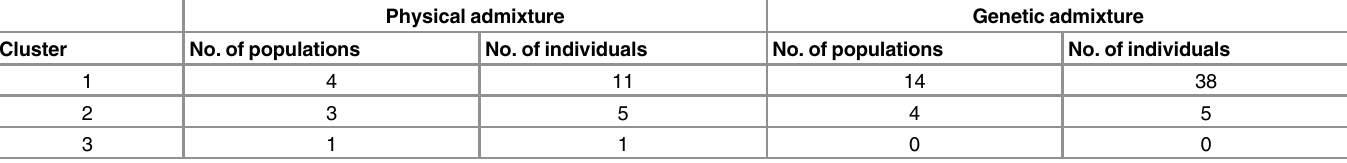
Table 4. Genetic and physical admixture. Physical admixture Genetic